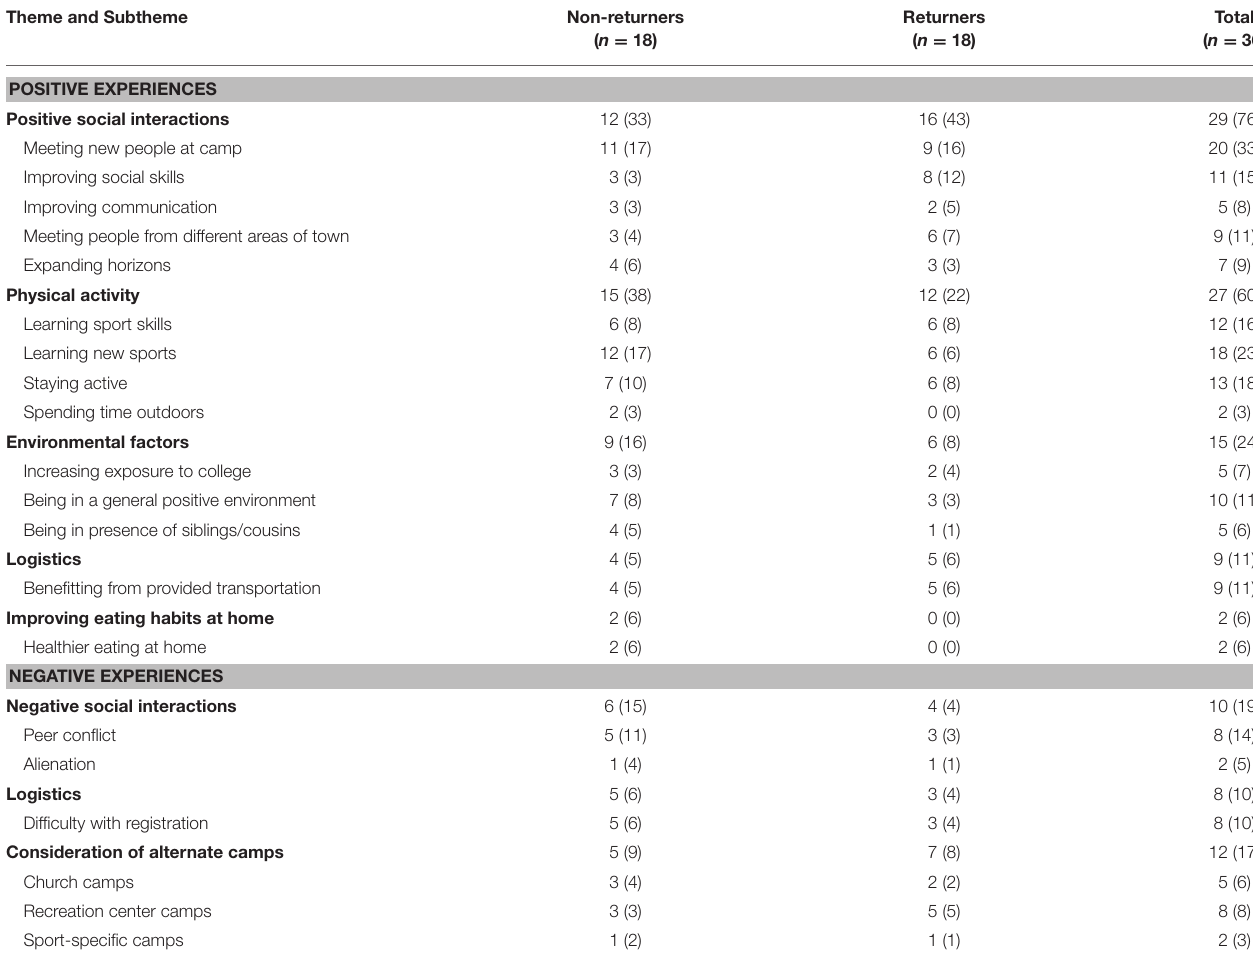
TABLE 3 | Qualitative content analysis